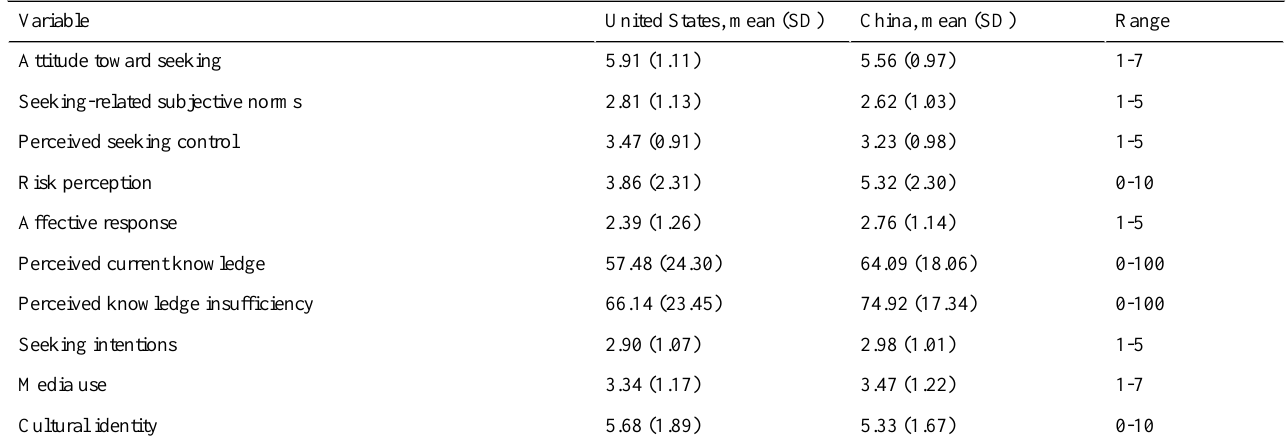
Table 1. Basic descriptive